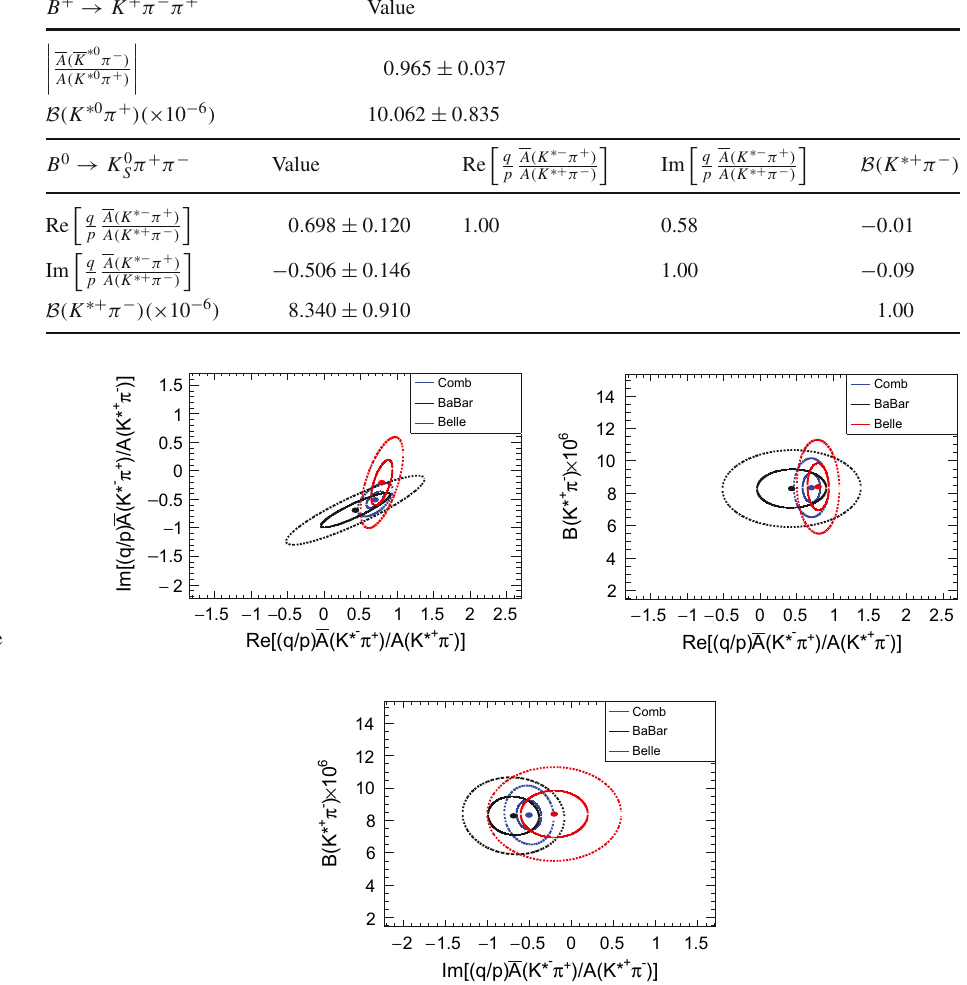
Table 9 Central values of the observables from the B + → K + π − π + (top) and π + π − (bottom) B 0 → K 0 S analysis obtained by combining BaBar and Belle results